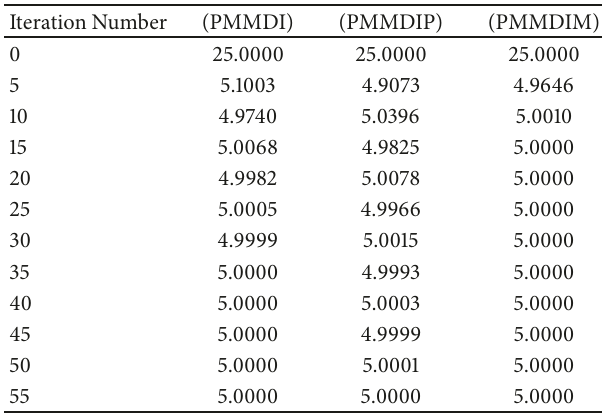
Table 1: A comparison of (PMMDI), (PMMDIP), and